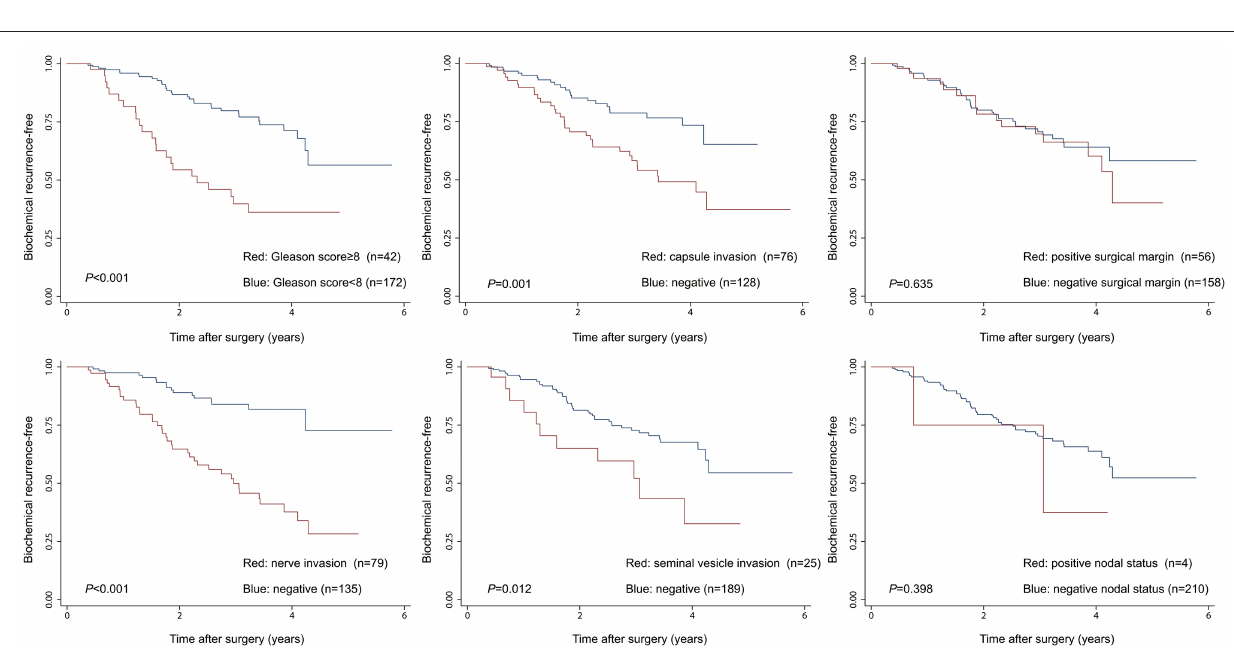
FIGURE 2 | The Kaplan-Meier analysis for BCR-free survival according to clinicopathological PCa features. The log-rank test was performed to determine the statistical significance between the two